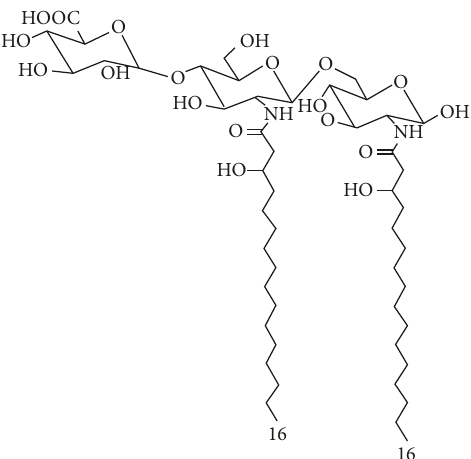
Figure 4: Proposed structure of lipid A from Oscillatoria Plank- tothrix